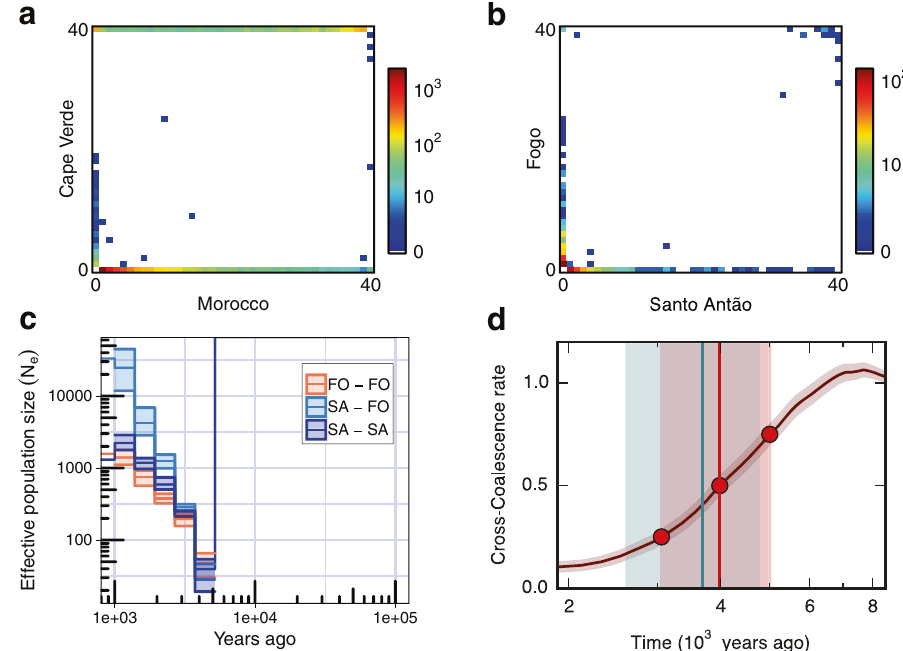
Fig. 2 Demographic history of Cape Verde Arabidopsis . a Joint site frequency spectrum between Cape Verde and Morocco and, ( b ), between the two islands, Santo Antão and Fogo. The colour scale represents the number of variants in each frequency class. c Historical population size trajectories within (SA-SA, FO-FO) and between islands (SA-FO) inferred from RELATE. Shaded areas represent the 95% CI calculated from the genome-wide distribution of coalescence events. d Estimated split times between islands from MSMC-CCR (point estimate at the vertical red line (4.0 kya), 0.25 – 0.75 cross- coalescence rate quantiles shown as shaded red area (3.1 – 5.0 kya)), and dadi (point estimate at the vertical blue line (3.7 kya), 95% CI as shaded blue area (2.6 – 4.8 kya)). Source data are provided as a Source Data fi Between the two islands, patterns of variation differ, with Santo Santo Antão, based on haplotype divergence among subpopula- Antão displaying a higher proportion of private variation at tions. The overall pattern suggests early population subdivision segregating sites and Fogo displaying a higher proportion of followed by later population expansion across the island, with N e increasing sharply in the past 3 ky (Fig. 2c). In Fogo, the more private fi xed variants (Fig. 2b). Consistent with this, we found arid island, there is no evidence of early separation into evidence for deep population structure and restricted gene fl ow in